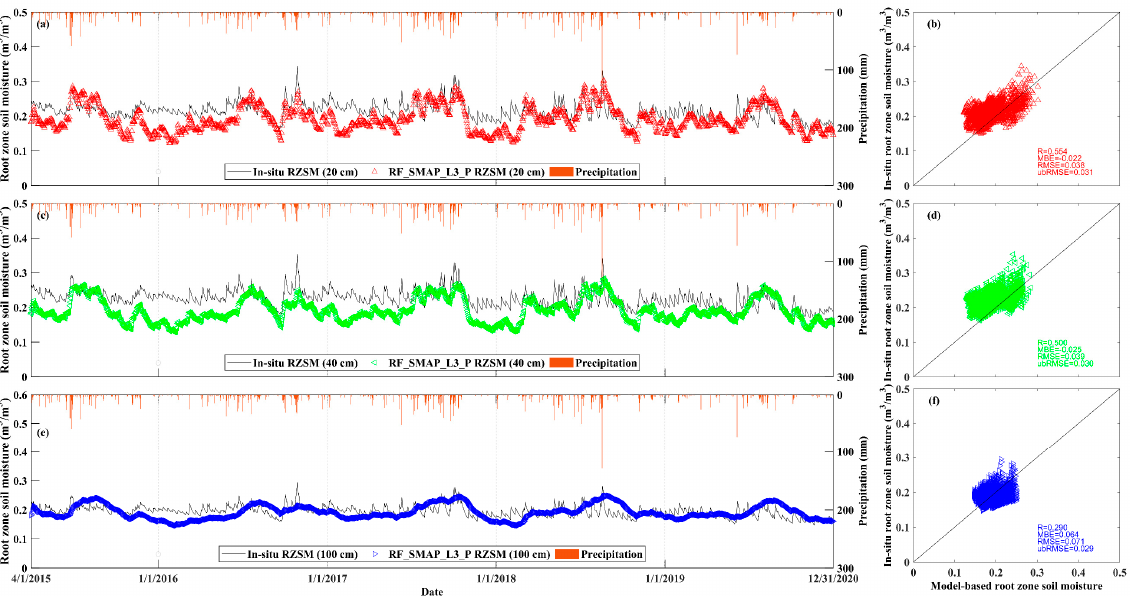
Figure 10. Left panel ( a , c , e ) shows the time series comparison between in situ RZSM and RF_SMAP_L3_P RZSM at depths of 20, 40 and 100 cm; right panel ( b , d , f ) is for the scatterplot.